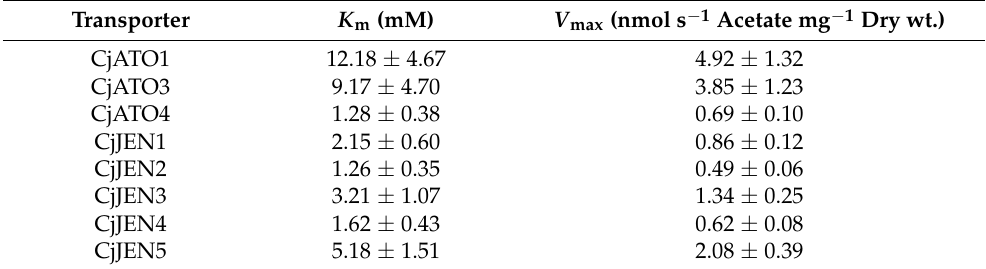
Table 3. Kinetic parameters for 14 C-acetic acid (pH 6.0) transport estimated in the cells of S. cerevisiae W303-1A jen1 ∆ ato1 ∆ expressing the CjATO1 , CjATO3 , CjATO4 , and CjJEN1-5 proteins. Cells were grown on glucose until the mid-exponential growth phase and shifted to YNB acetate (0.5%, pH 6.0) for 6 h.